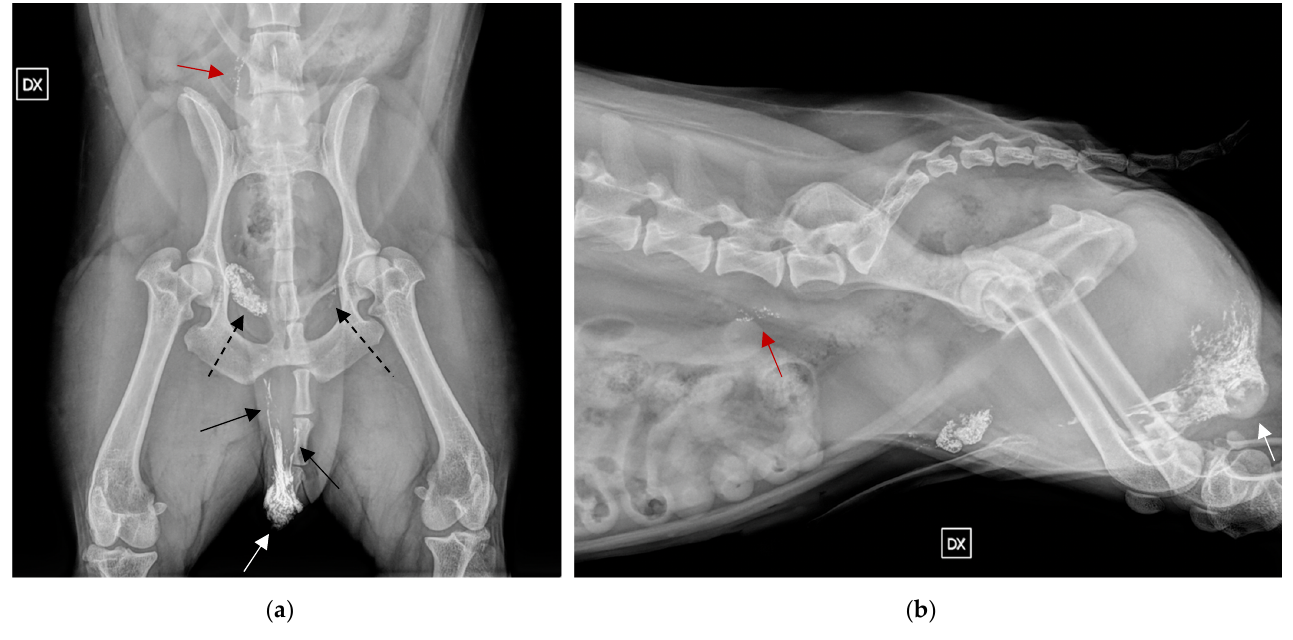
Figure 2. Number of SLNs detected with radiographic indirect lymphangiography. Abbreviations: SLN, sentinel lymph node; MCT, mast cell tumour.